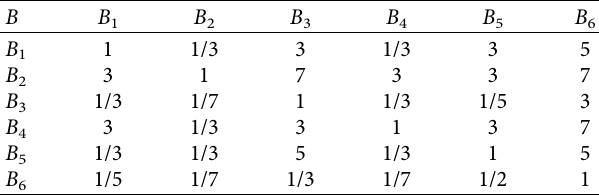
Table 17: B – B 1-6 judgment matrix.